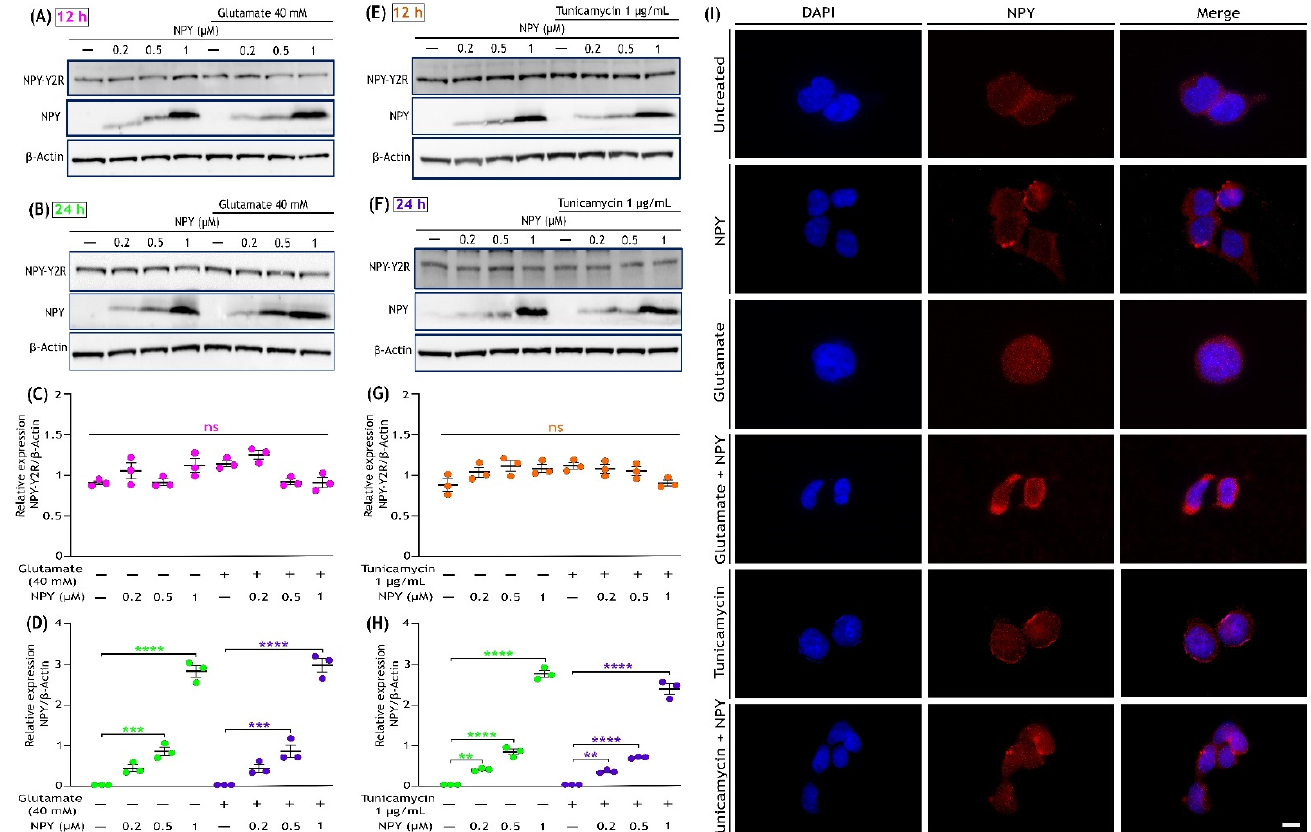
Figure 7. Expression of Neuropeptide Y and NPY-Y2R receptor in SH-SY5Y cells. ( A , B ) Western immunoblot analysis illustrates the presence of NPY-Y2R in all indicated groups (Control, Control + NPY, glutamate, and glutamate + NPY) and dose-dependent increase in the NPY expression with NPY treatment at 12 and 24 h, respectively. ( C , D ) Densitometric quantification of NPY-Y2R blot intensities represent that its expression was not affected by either the insults (glutamate or tuni- camycin) or the NPY treatment at 12 h (F(3,16)= 5.461 in Figure ( C ) and F(3,16) = 1.265 in Figure ( D ), ns represents non-significance, n = 3). ( E , F ) Western immunoblot analysis illustrates the presence of NPY-Y2R in all indicated groups (Control, Control + NPY, tunicamycin, and tunicamycin + NPY) and dose-dependent increase in the NPY expression with NPY treatment at 12 and 24 h, respec- tively. ( G , H ) Densitometric quantification of NPY blot intensities showed a progressive dose-de- pendent significant increase in its expression with NPY treatment (F(3,16)= 264.8 in Figure ( G , F ) (3,16) = 697.9 in Figure ( H ), ** p < 0.01, *** p < 0.001, **** p < 0.0001 represents significance between control and NPY group (green), ** p < 0.01, *** p < 0.001, **** p < 0.0001 represents significance between insults (glutamate or tunicamycin) and insults + NPY (purple), n = 3) and no expression in untreated cells or in cells exposed to only insults (glutamate or tunicamycin). Each band intensity was normalized to the respective band intensity of β -actin. ( I ) Immunofluorescence images (repre- sentative) of treated SH-SY5Y cells showing the expression of NPY. After 12 h of treatment, cells were fixed and immunostained with an anti-NPY antibody (red). Nuclei were stained with DAPI (blue). Scale bar = 10 µm. 4. Discussion